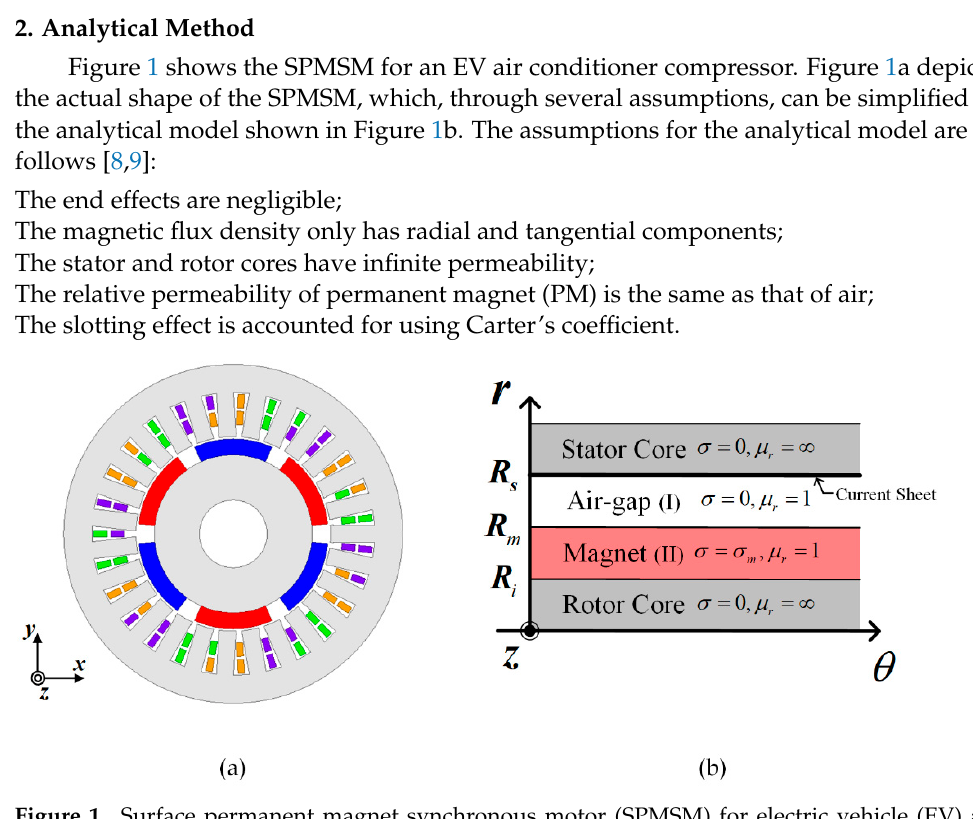
Figure 1. Surface permanent magnet synchronous motor (SPMSM) for electric vehicle (EV) air conditioner compressor ( a ) Analysis model ( b ) Simplified slot less analytical model.